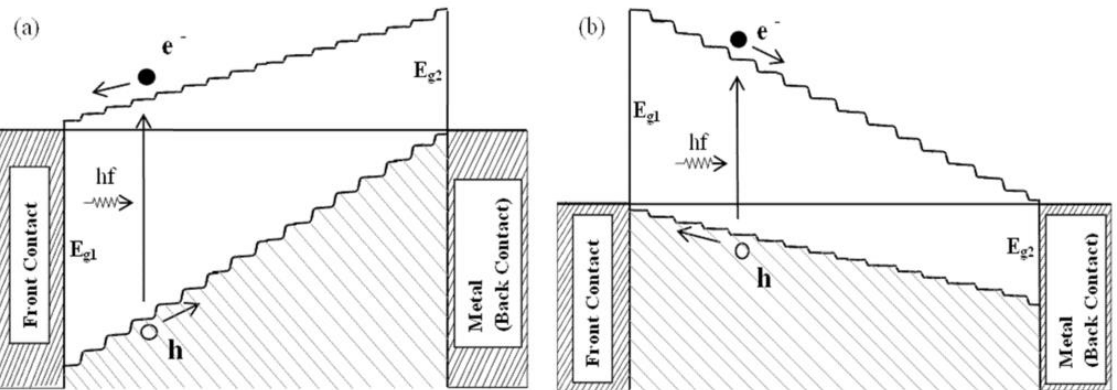
Figure 10. Energy band diagrams of graded bandgap devices based on ( a ) n-type window material and ( b ) p-type window material. Note that the number of potential barriers achievable for electron transport is higher in devices based on p-type window materials [6,7,38].